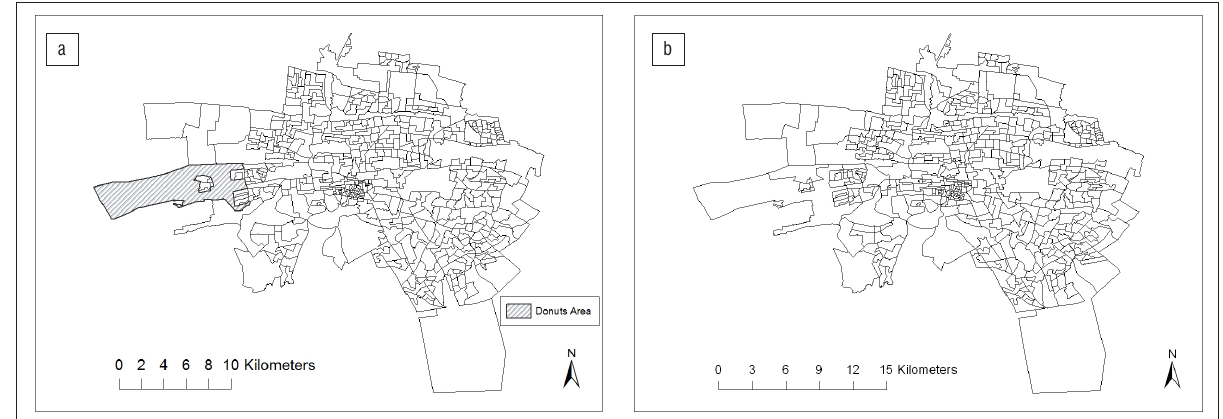
Newly created output areas for Pretoria MainPlace: (a) with donuts allowed, (b) with donuts not